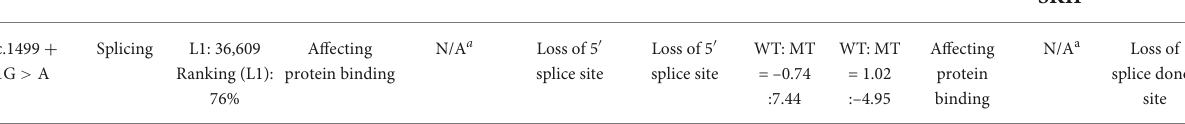
TABLE 1 In silico analysis prediction results of the variants in the SLC4A4